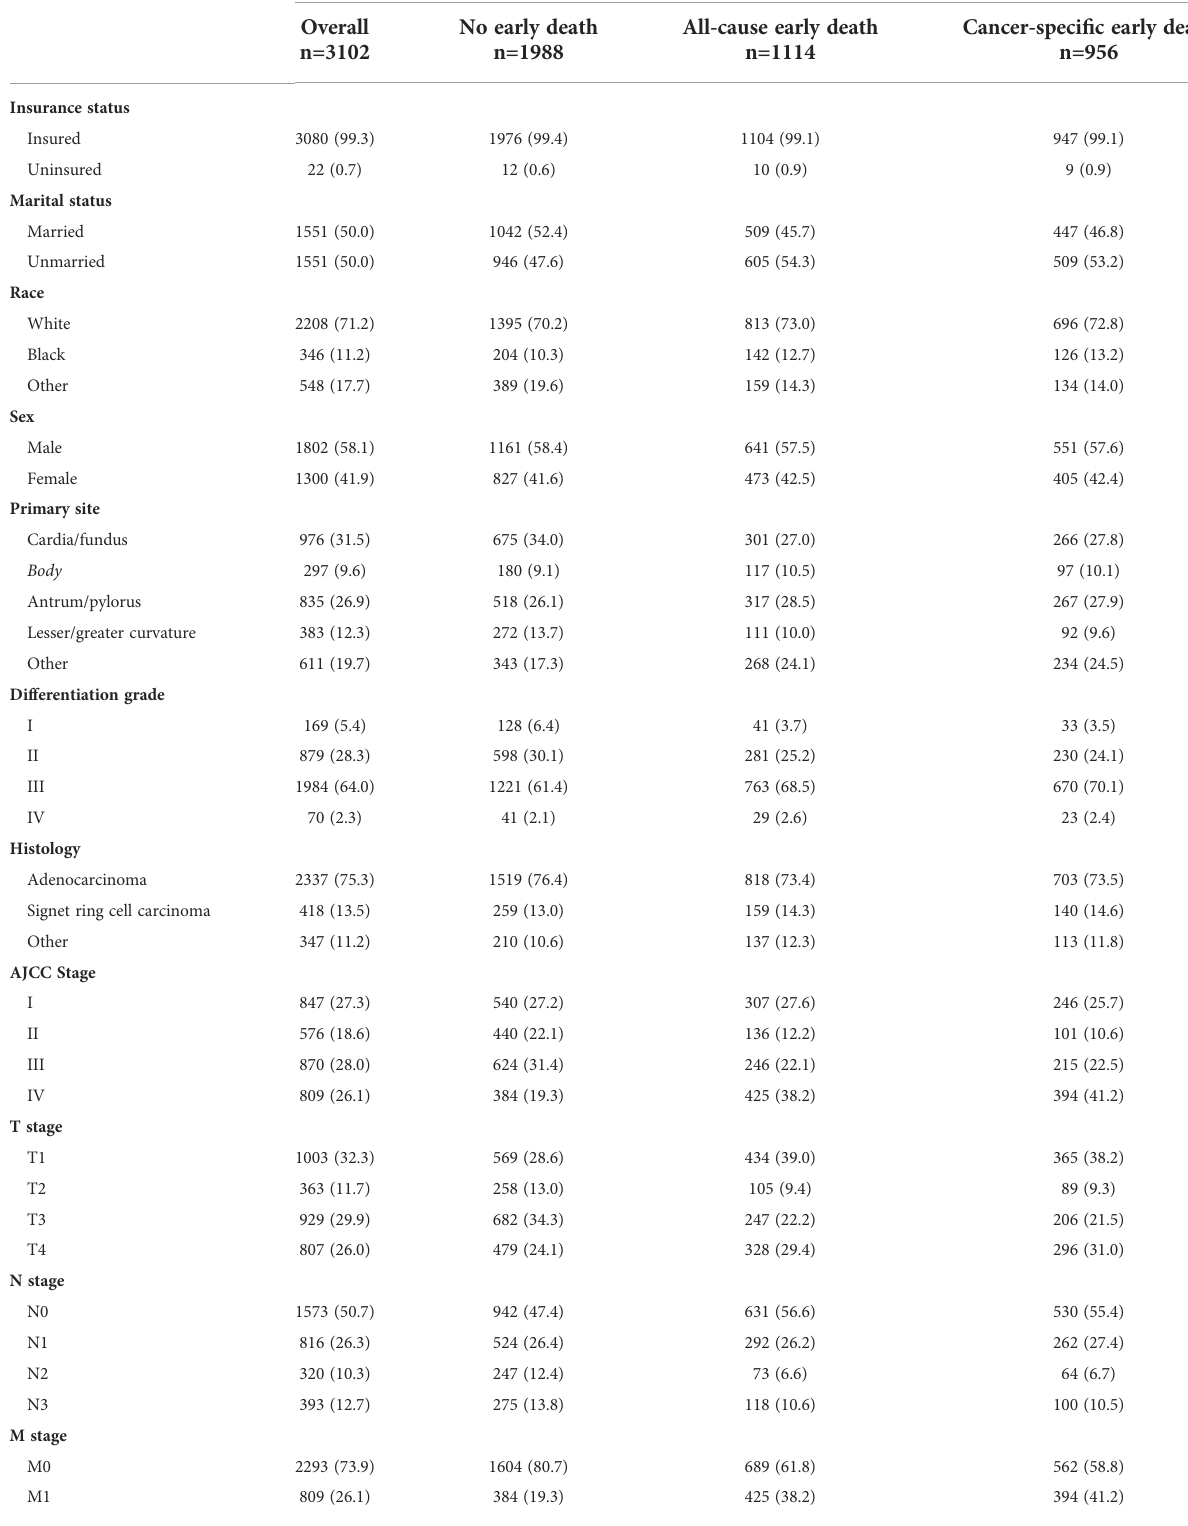
TABLE 1 Demographic and clinicopathological characteristics of elderly GC patients with or without early